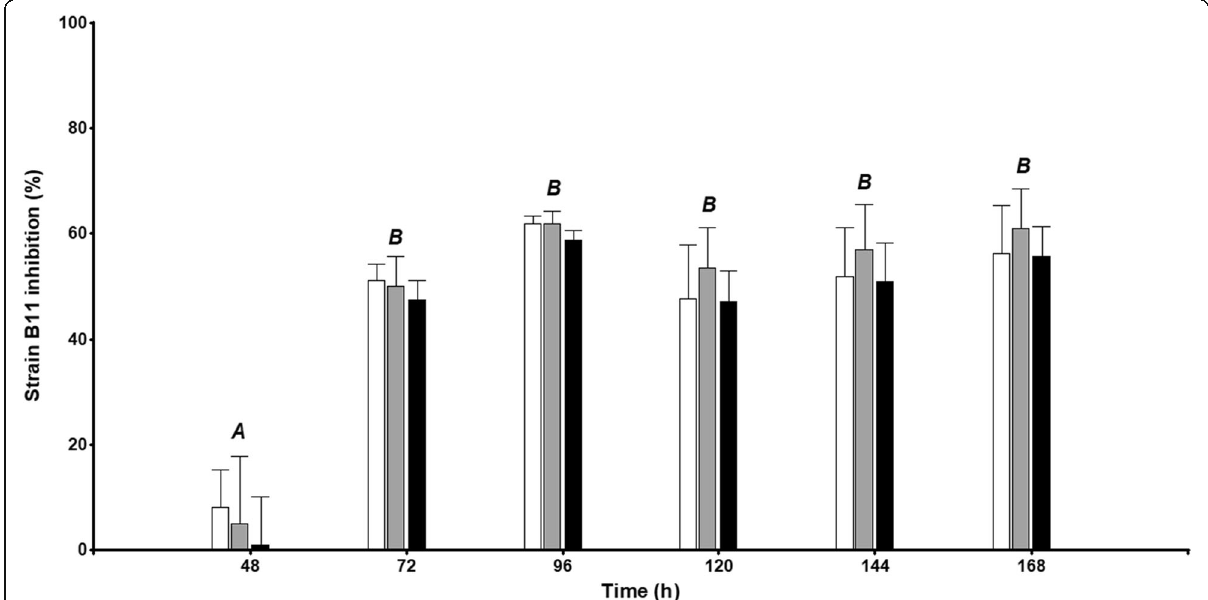
Fig. 2 Percent inhibition of Botrytis cinerea strain B 11 caused by three entomopathogenic fungi . Error bars represent the standard deviation for three replicates. Different letters indicate significant differences among the time stages (LSD Fisher 0.05). Control treatments (not shown) represent 0% inhibition, and they were statistically different from the three fungal treatments. Columns represent inhibition percentage given by CEP413 (white), CEP589 (gray), and CEP591